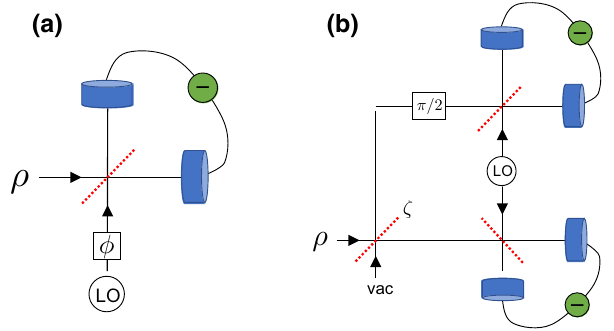
FIG. 1. Phase-space measurements. (a) Homodyne detection of the rotated quadrature ˆ x φ . (b) Double homodyne detection with unbalancing parameter ζ . The dashed red lines represent beam splitters and LO stands for local oscillator, i.e., a strong coherent